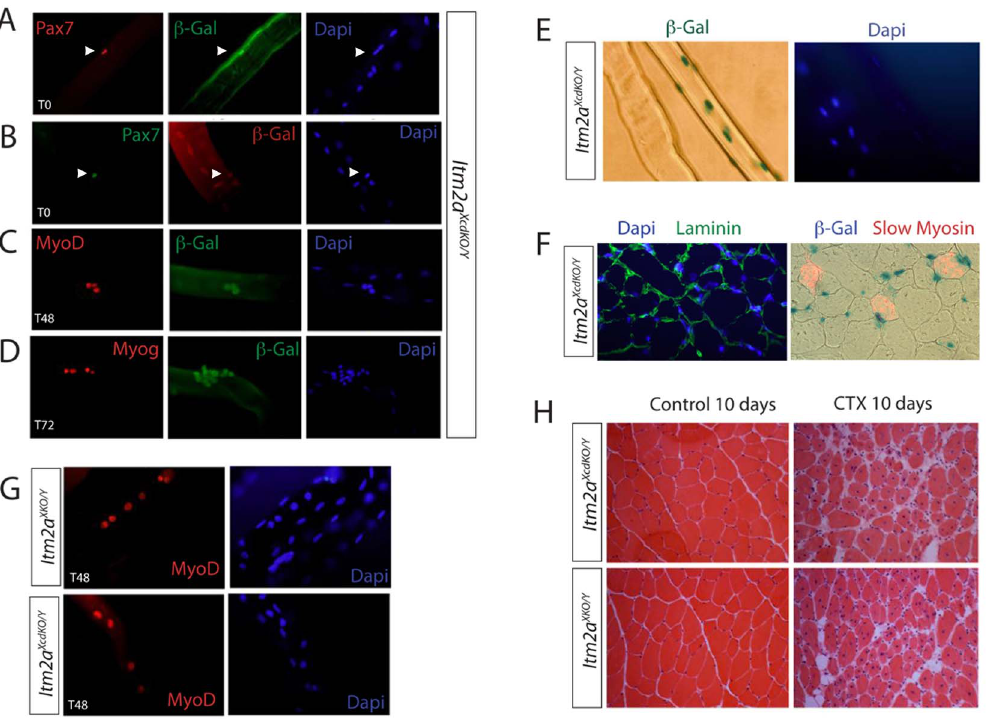
Figure 4. Itm2a is expressed in adult skeletal muscles. A–D, Immunohistochemistry on isolated single fibers from the EDL muscle of adult Itm2a XcdKO/Y mice immediately after isolation (T0) (A, B), or after 48 h, (T48) (C) or 72 h (T72) (D) culture, using Dapi staining (blue) and antibodies recognizing Pax7 (red, A, green B), b -Gal (green, A, C, D, red, B), MyoD (red, C) and Myogenin (red, D). Arrowheads point to Pax7-positive satellite cells (A,B). E, X-Gal staining for b -Gal on isolated single EDL fibers from adult Itm2a XcdKO/Y mice at T0 showing examples where the myonuclei are positive or negative. Dapi is shown in blue. X-Gal positive staining quenches DAPI. F, Immunohistochemistry on transverse sections of EDL muscle isolated from adult Itm2a XcdKO/Y mice with Dapi staining (blue), and antibodies recognizing Laminin (green) (left) or slow myosin heavy chain (red) and b -Gal (blue) (right) as indicated. G, Immunohistochemistry experiments on isolated single fibers from adult Itm2a XcdKO/Y and Itm2a XKO/Y mice after 48 h culture (T48) with Dapi (blue) and an antibody recognizing MyoD (red). H, Eosin-hematoxylin staining on transverse sections of the EDL muscle isolated from adult control Itm2aXcdKO/Y (top) and Itm2aXKO/Y (bottom) mice, 10 days after cardiotoxin injury (CTX) (right) or PBS injection (control) (left). Dapi staining (blue) marks nuclei. In G and H the mice were crossed with the PGK-Cre line to delete the floxed Itma2